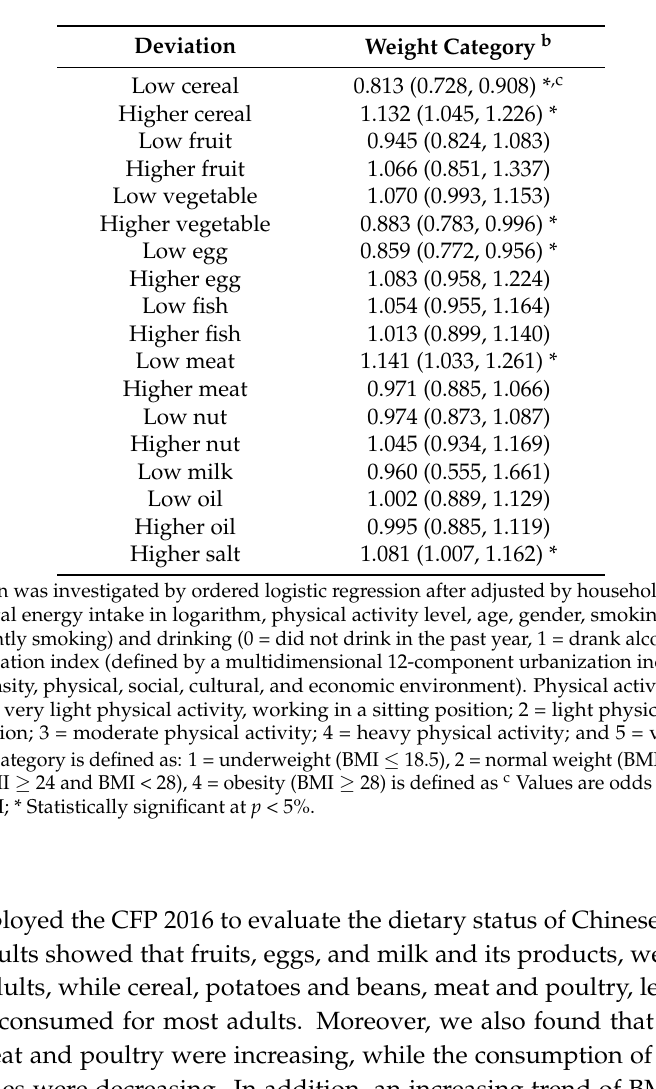
Table 3. Association between weight category and the deviation of food consumption from CFP a